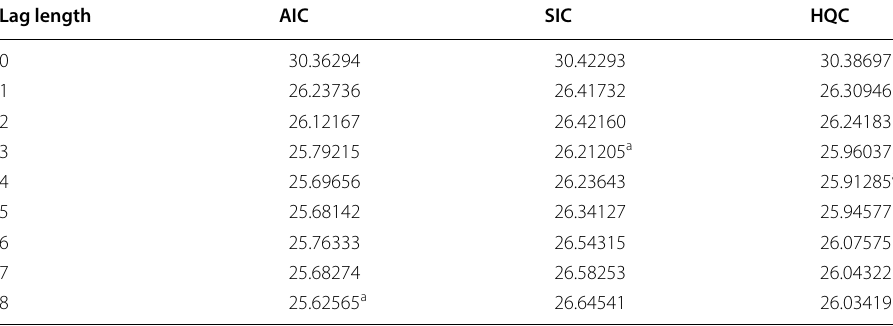
Table 4 VAR lag order selection criteria for FDI and FT. Source: Calculated by authors Lag length AIC